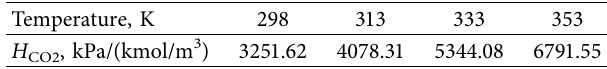
2 Henry’s coefficients in 20 wt. % aqueous MEA